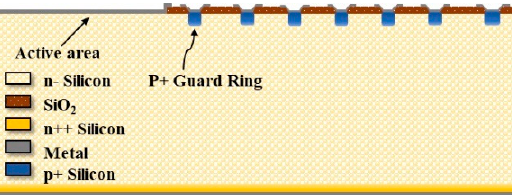
Figure 2. Simulation geometry, 2 − D view of half − infinite and symmetric Hybrid − SSBD structure consisting of a Schottky diode as the sensor surrounded with 7 PN junction guard rings (the blue area of the p+ implantation area).